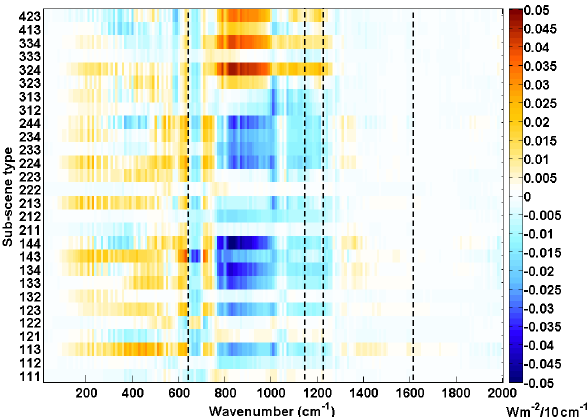
Figure 3. The mean differences between the predicted spectral fluxes based on synthetic AIRS spectra and the directly computed fluxes for different sub-scene types. The naming convention of sub- scene types is defined in Table 3. The spectral flux is for every 10cm − 1 interval from 10 to 2000cm − 1 . Spectral bands between two pairs of dashed lines are covered by the AIRS